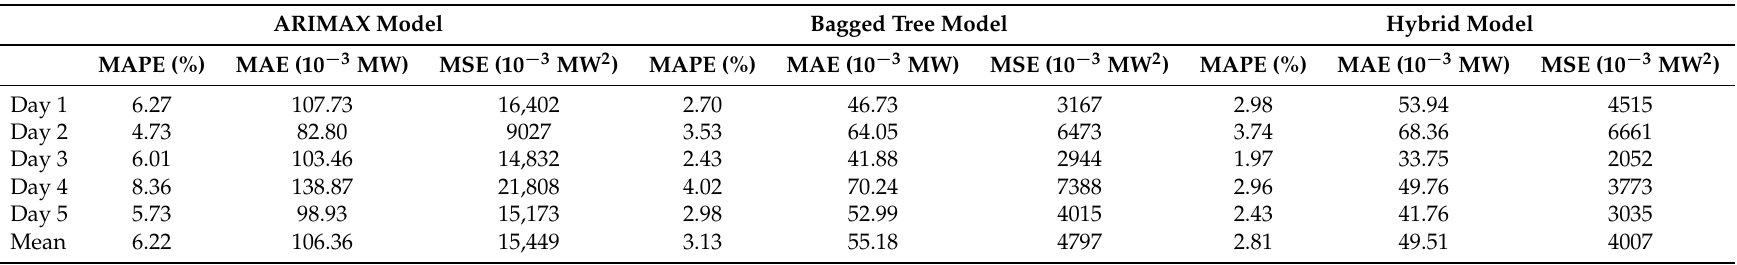
Table 5. Errors achieve by the models. (Mean Absolute Percentage Error (MAPE), the Mean Absolute Error (MAE), the Mean Square Error (MSE), and the Maximum Error